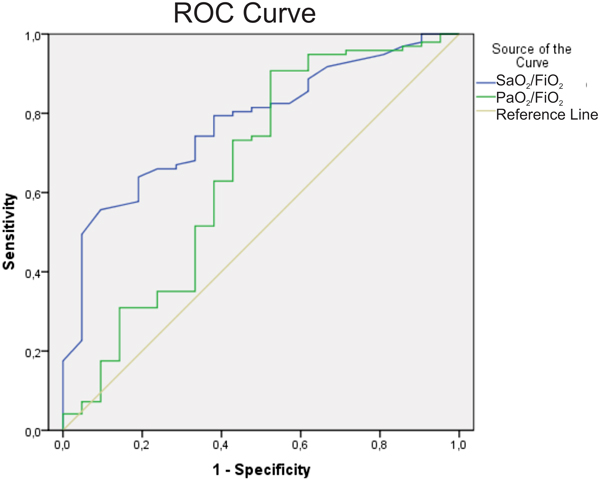
ROC curve for SaO2/FiO2 and PaO2/FiO2.